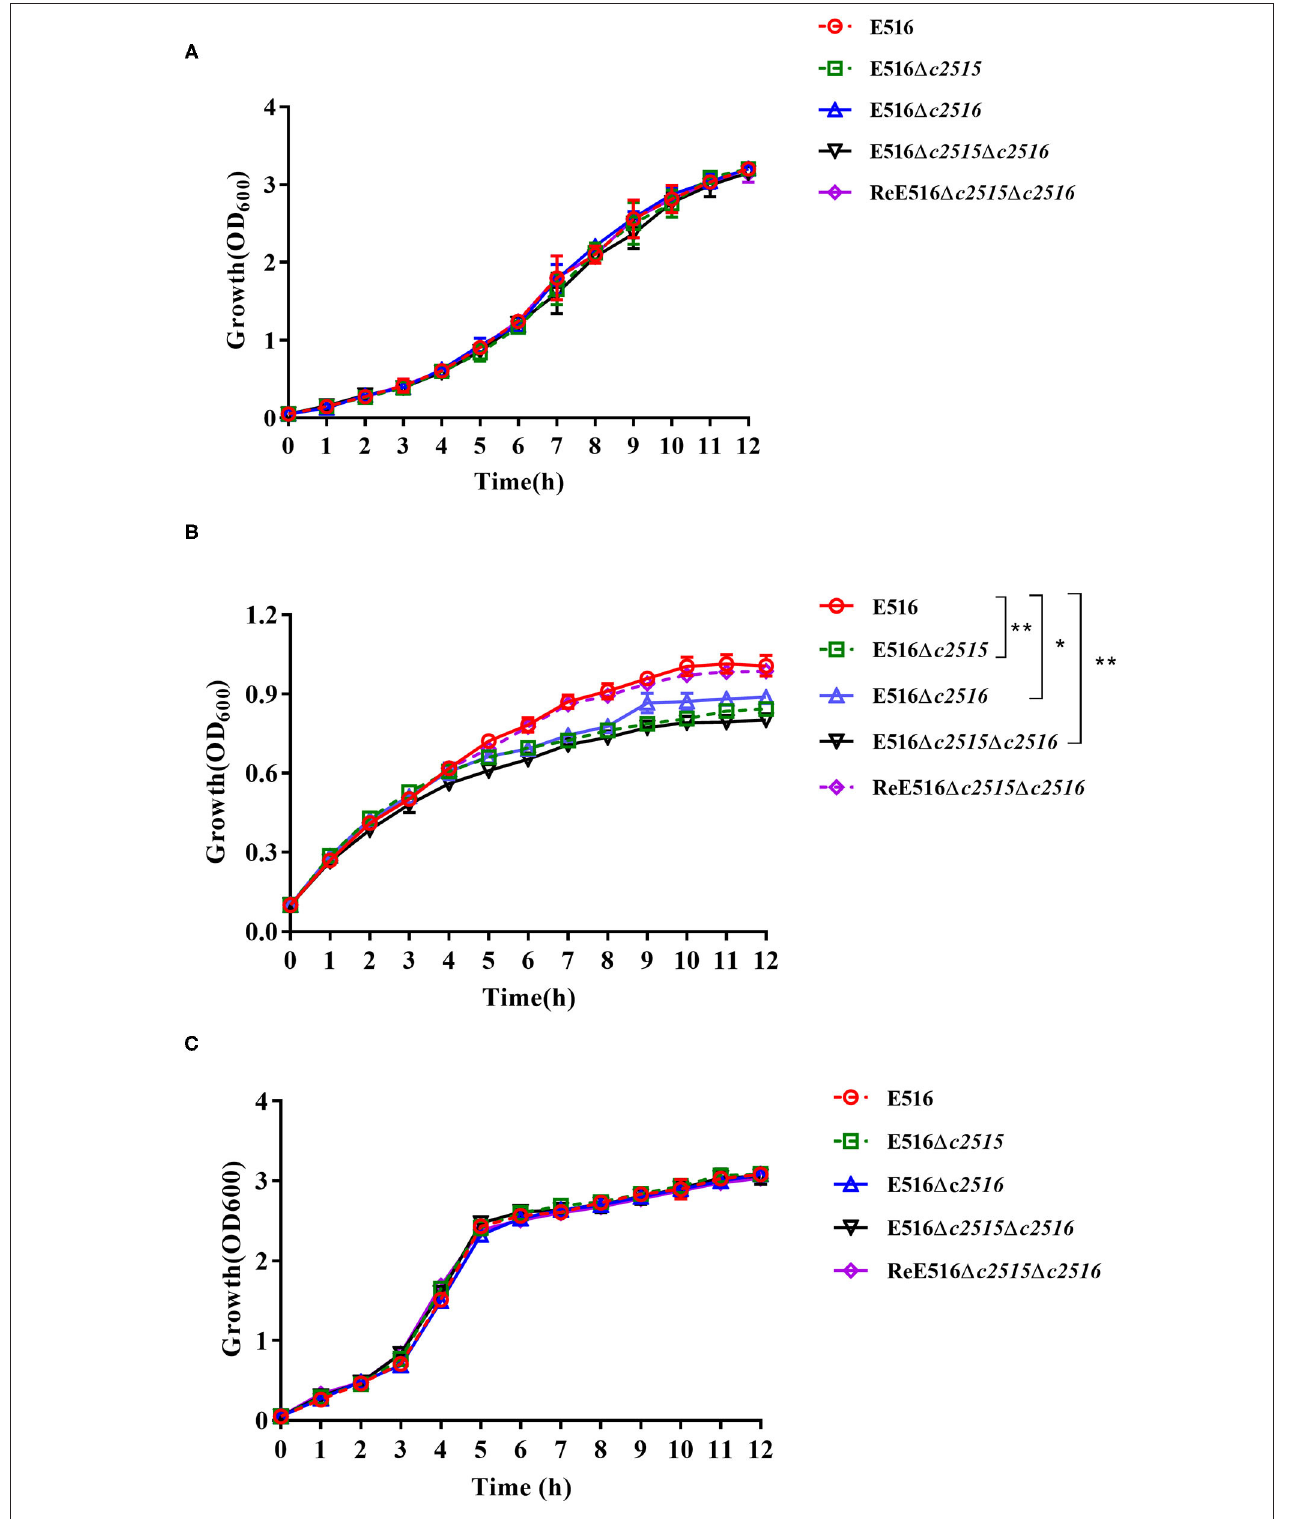
FIGURE 2 | Growth curves of E516 wild-type strain and its mutants. (A) The E516, 1 c2515 , 1 c2516 , 1 c2515 1 c2516 , and Re 1 c2515 1 c2516 strains were grown in LB broth at 37 ◦ C, and their growth was determined by measurement of optical density at 600nm (OD 600 ). (B) Growth curves of the E516 and its mutants in iron-depleted MM9 medium. (C) Growth curves of the E516 and its mutants in iron-depleted MM9 medium supplemented with 100 µ M FeCl 3 . The data represent averages of three independent assays (* P < 0.05,** P < 0.01).